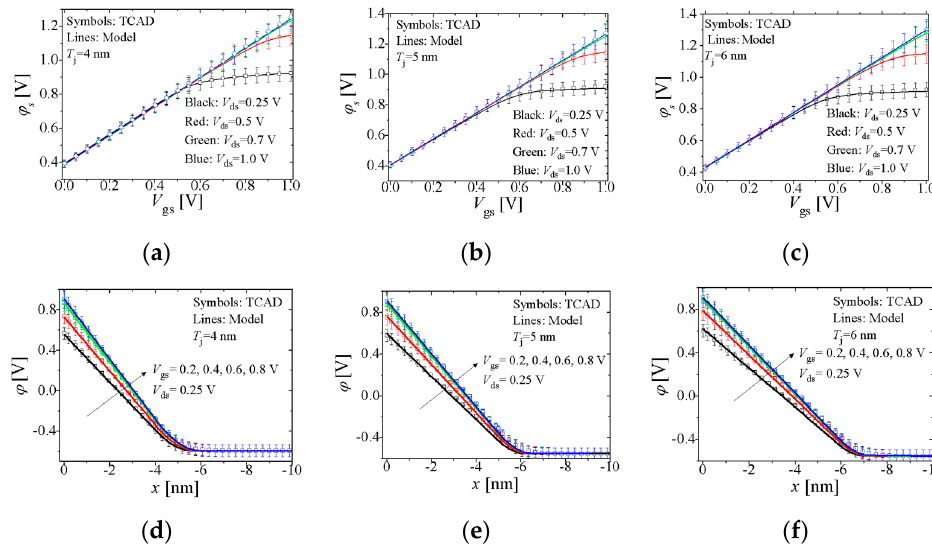
Figure 5. ( a – c ) φ s as a function of V gs , for T j = 4, 5, and 6 nm, respectively, at V ds = 0.25 (black), 0.5 (red), 0.7 (green) nm, and 1 V (blue). Error bar: 5%. ( d – f ) potential profile in channel, and source regions, for T j = 4, 5, and 6 nm, respectively, at V gs = 0.2 (black), 0.4 (red), 0.6 (green), and 0.8 V (blue) at V ds = 0.25 V. Error bar: 10%. Lines: Potential model. Symbols: technology computer-aided design (TCAD). Figure 5d–f is along the cutline of Figure 4b.